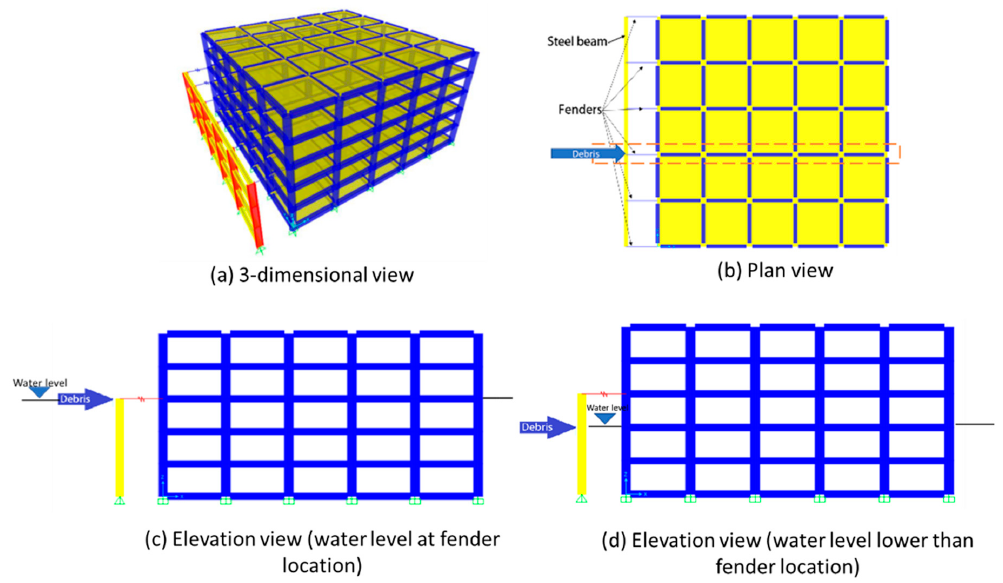
Figure 5. Two-dimensional model of the building with a fender structure.